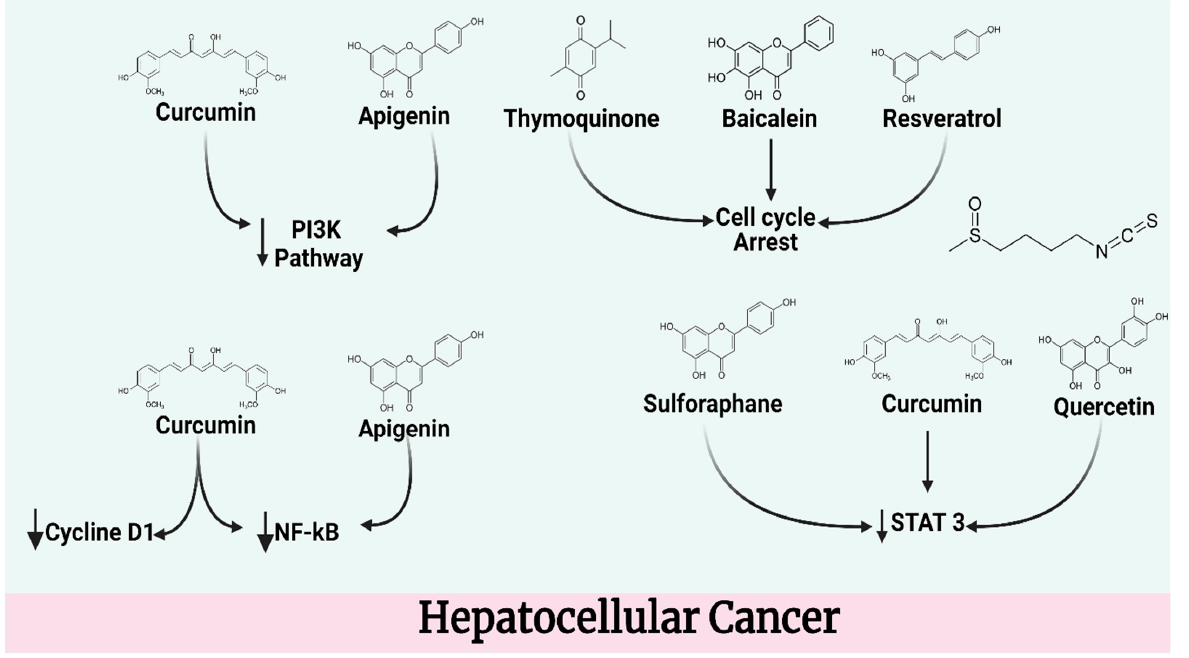
Figure 5 . Illustration representing the probable sites of blockade by small molecules in hepatocellu- lar cancer.